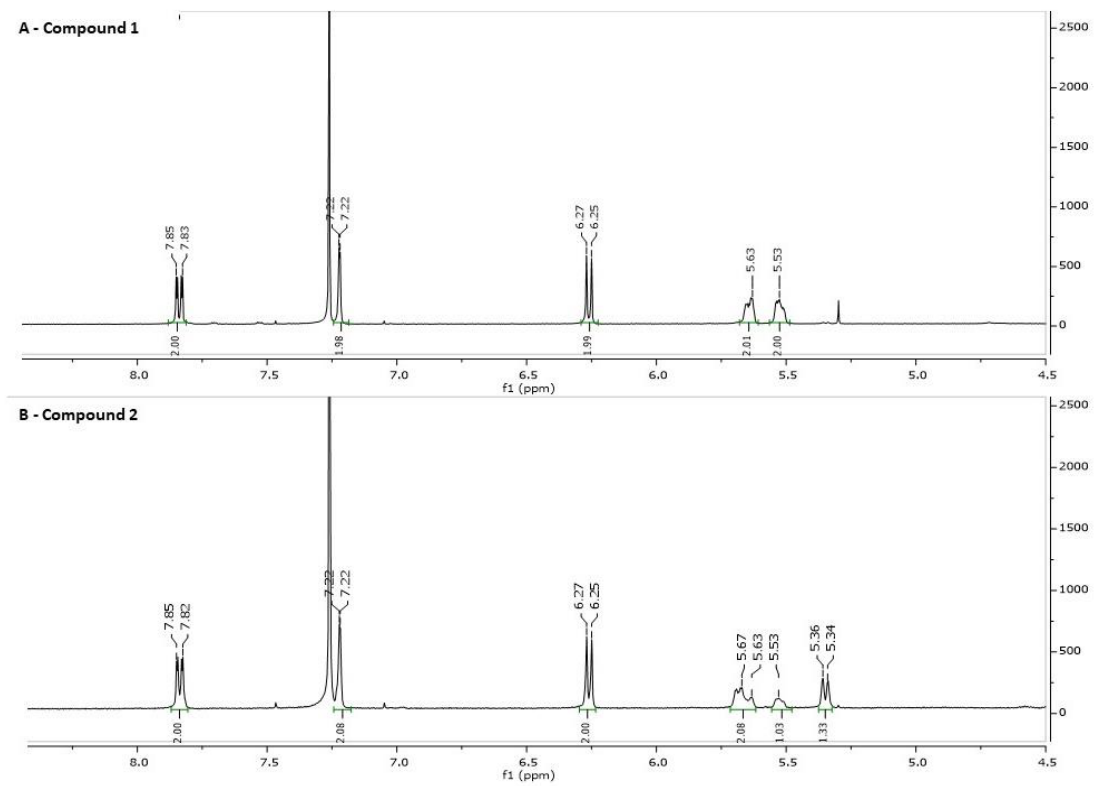
Figure 3. Proton NMR of bufalin 2,3-ene (Compound 1, A ) and bufalin 3,4-ene (Compound 2, B ). The compounds at retention time 24–25 min and 25–26 min in the HPLC were collected dried and dissolved in CDCl3 (1.0 mg/mL). Measurements were made with a Bruker AVANCE III HD 500 MHz spectrometer in CDCl3.